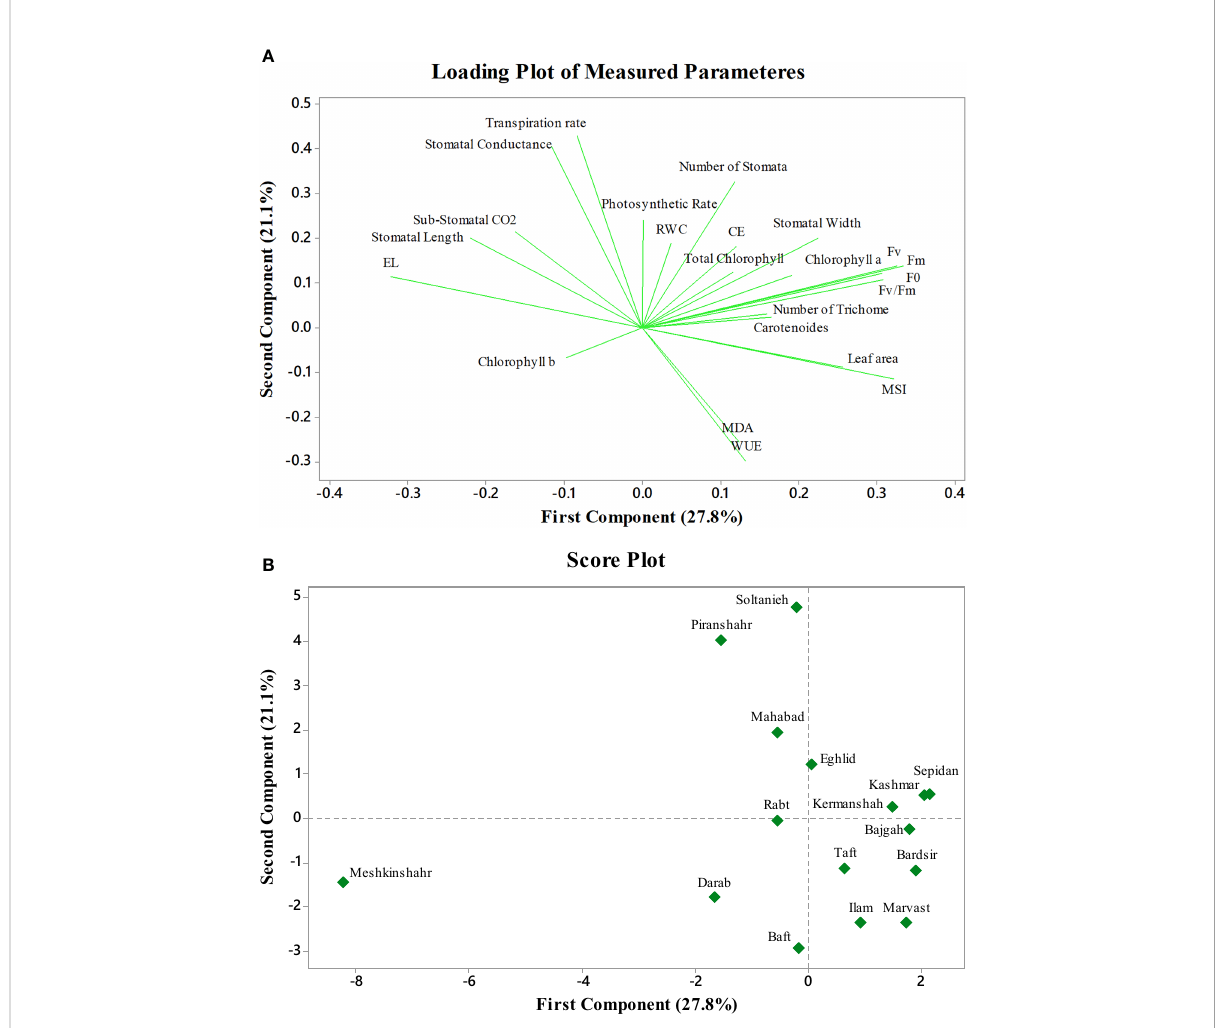
FIGURE 6 Principal component analysis of Azotobacter and salinity stress on 16 licorice accessions. (A) : Loading plot of measured parameters. (B) : Score plot of studied accessions. CE (Carboxylation Ef fi ciency), EL (Electrolyte Leakage), MSI (Membrane Stability Index), MDA (Malondialdehyde), WUE (Water Use Ef fi ciency), RWC (Relative water content), F0 (Initial fl uorescence intensity), Fv (Variable fl uorescence), and Fm (Maximal fl uorescence